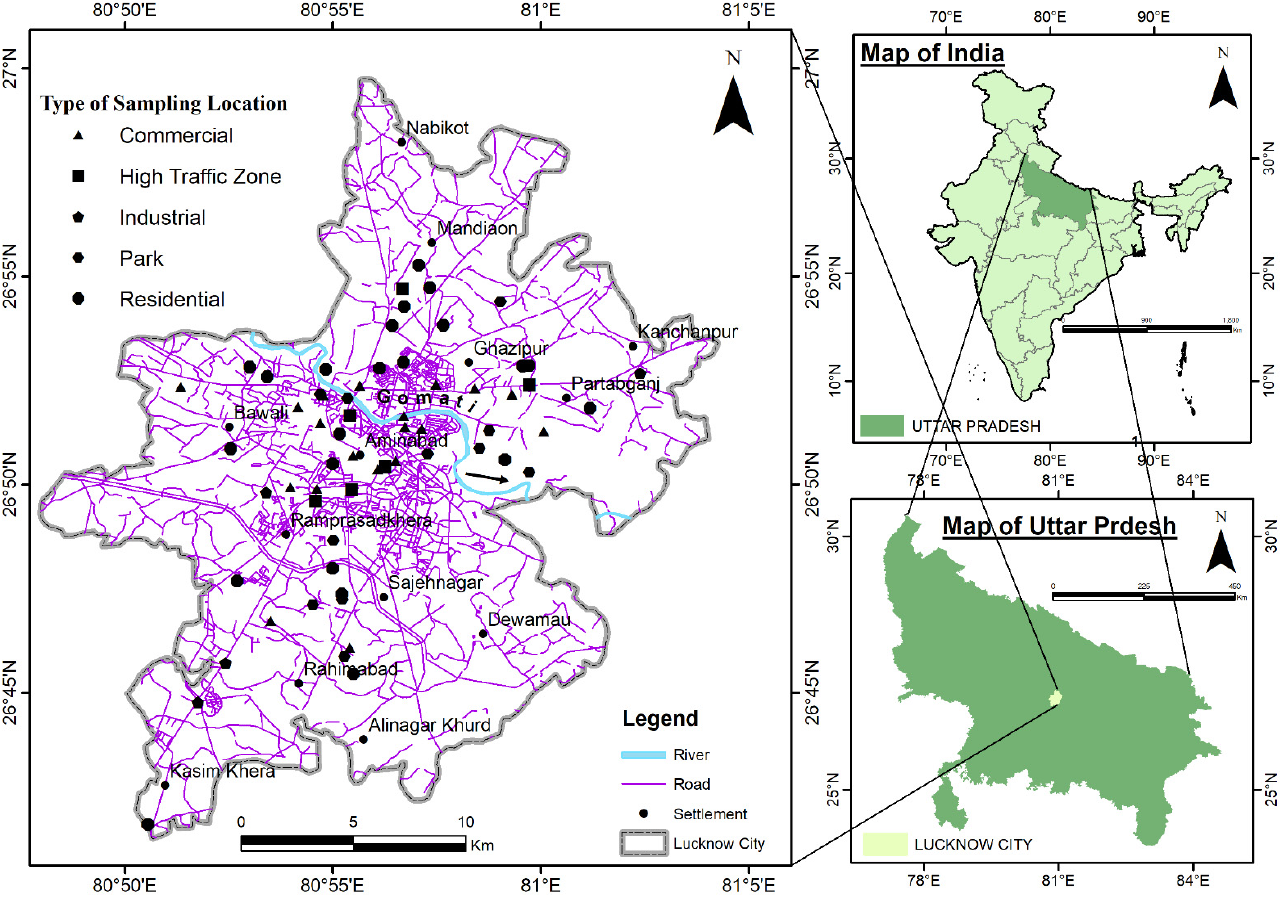
Figure 1. Map of the study area and sampling locations.